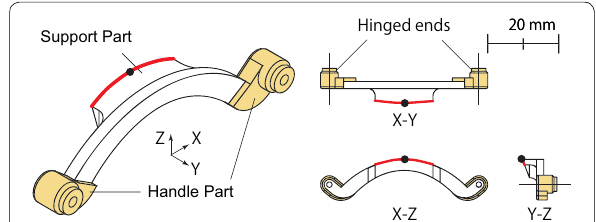
Fig. 3 Eyelid gating mechanism; the white part is the support part made of soft material, and the yellow parts are the handle parts made of rigid material. The red line shows the edge of the nob attached on eyelid. The dot is the center point of the edge